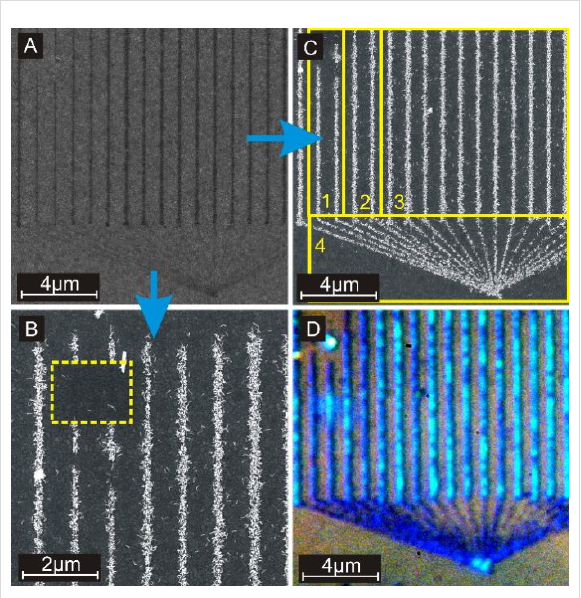
Figure 4: Panels A to C show SEM images. Panel A is the selectively scratched area before hydrothermal growth on an anatase layer. Panel B shows scratched lines after the hydrothermal growth process. Inside the yellow rectangle, the substrate was scratched in an identical way, but the growth was suppressed by an intensive electron-beam expo- sure. Panel C displays the area shown in panel A after the hydrother- mal growth process. The image is separated in different areas marked by yellow rectangles and labeled by yellow numbers. The lines in area 1 are scratched 32 times per line, in area 2, 64 times per line, in area 3, 128 times per line and in area 4, only twice per line. Panel D is a bright-field image taken with an optical microscope of the same area as shown in panel C. The colors in panel D were amplified subse-